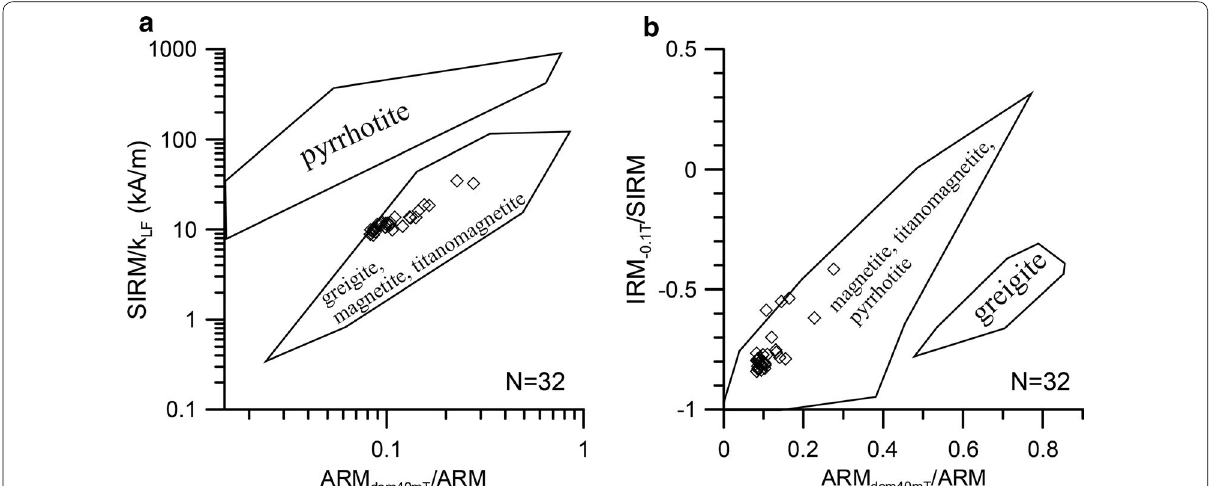
Fig. 8 a Biplot of SIRM/ k LF ratio versus ARM dem40mT /ARM ratio, and b biplot of IRM ‑0.1T /SIRM ratio versus ARM dem40mT /ARM ratio, which are suggested by Peters and Thompson (1998) to discriminate “low‑coercivity” magnetic minerals from each other, on the GSDS1 subsamples. Individual polygonal boxes denote the domains for identification of corresponding minerals from Peters and Thompson